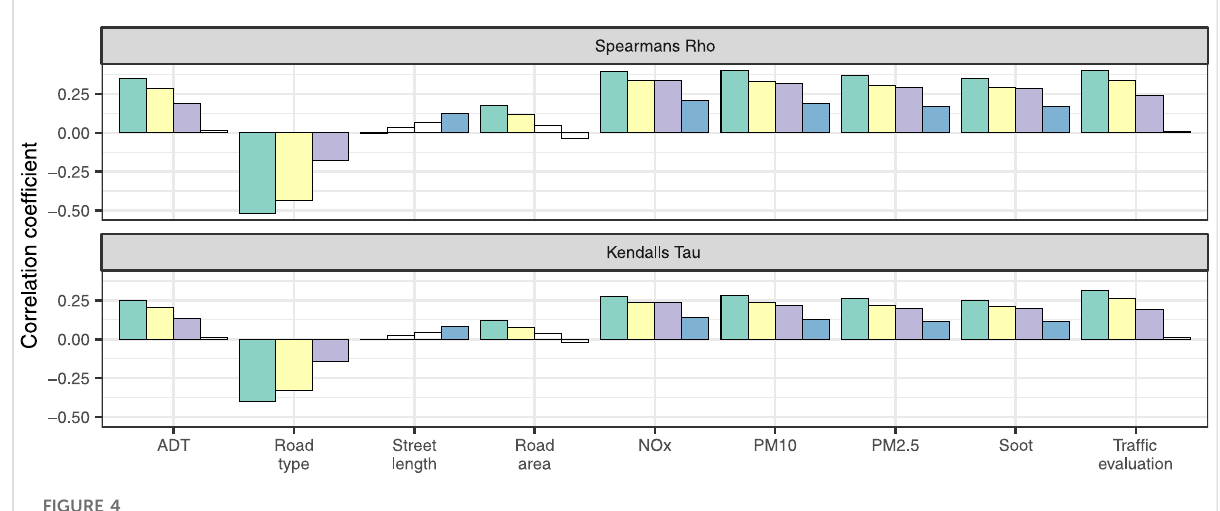
FIGURE 4 Rank correlations of PNC total /PNC total with spatial parameters for road traf fi c extracted from spatial data. Data of all 45 runs are averaged per track point and buffer size. Correlations are calculated per buffer size for each parameter, with radii from left to right: 50 (green), 100 (yellow), 250 (purple), and 500 m (blue). Bars with a p -value < .05 are displayed without color.